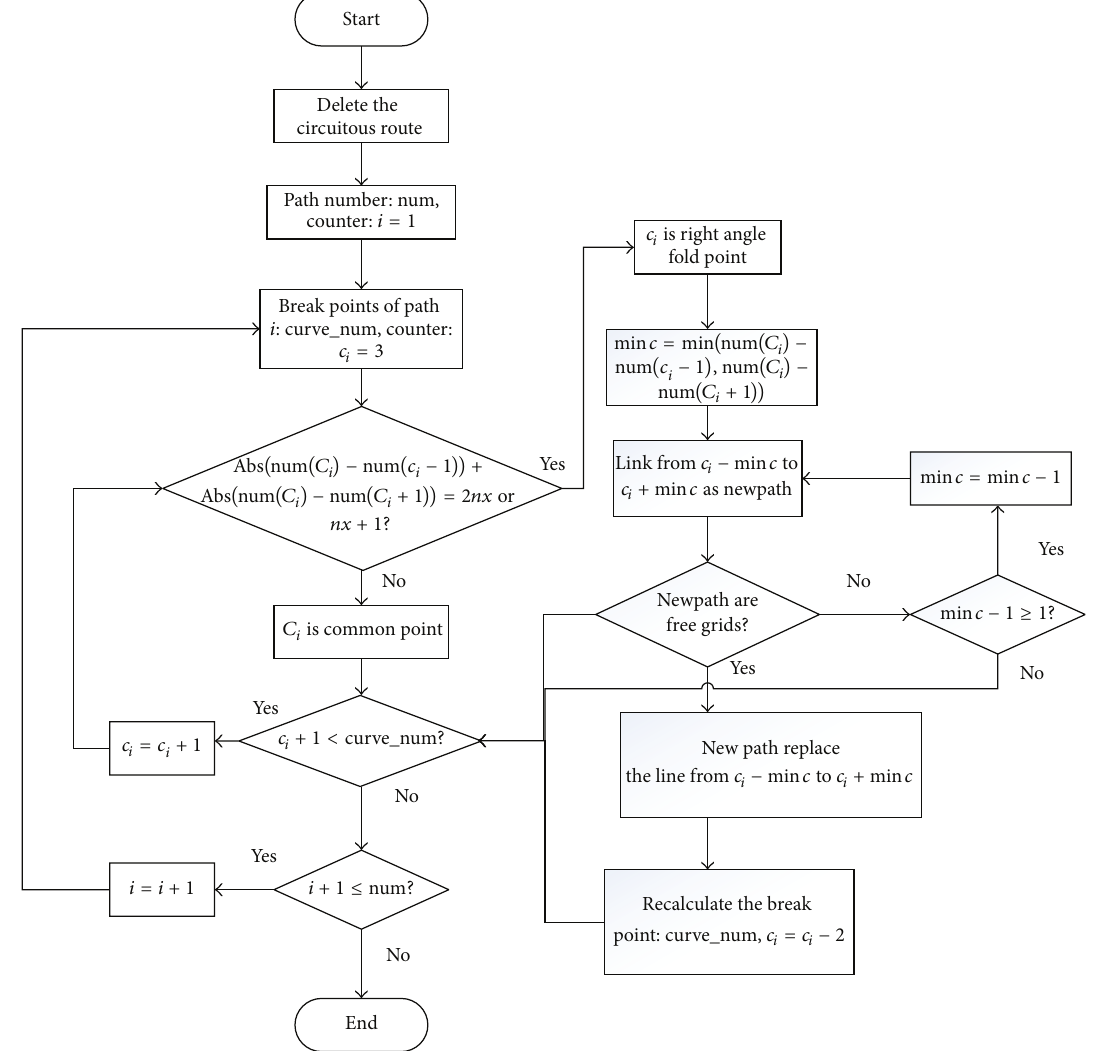
Figure 7: Flow chart of right angled triangle optimization